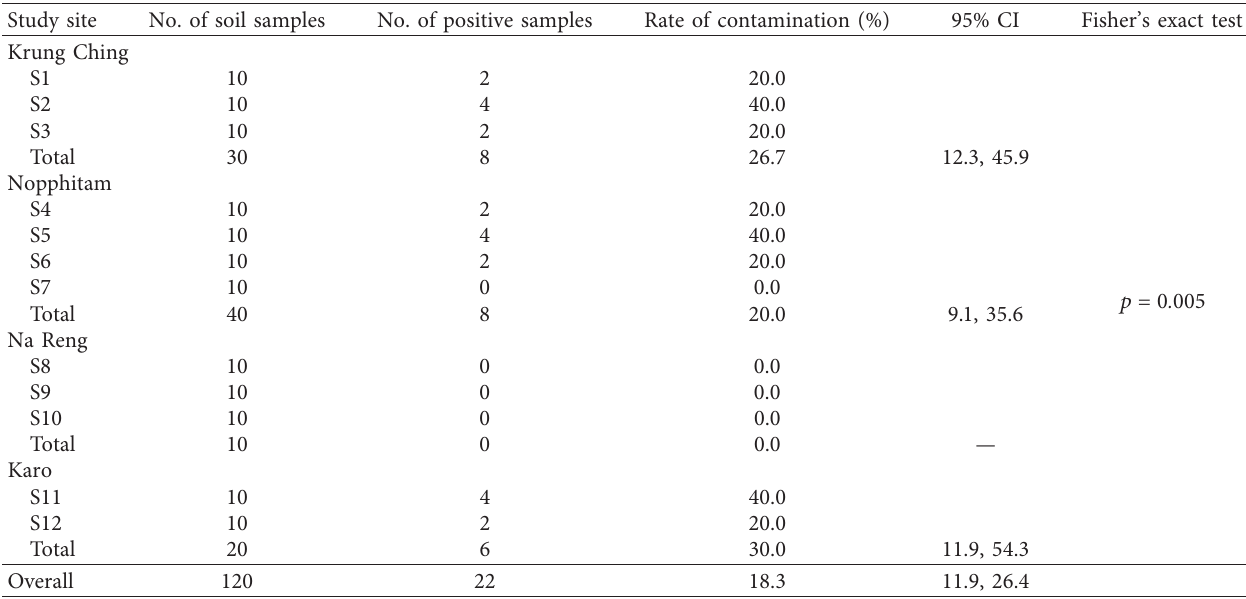
Table 1: Soil contamination by Toxocara eggs in the subdistricts and public schools in Nakhon Si Thammarat province in southern Thailand. Study